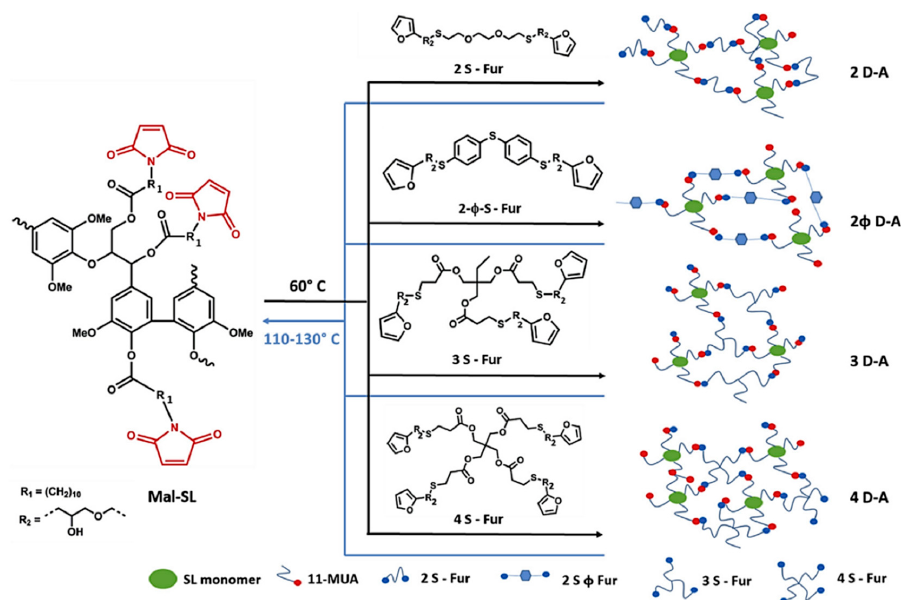
Figure 35. Thermo-reversible D-A polymerization of maleimide grafted lignin with the multifunctional furan linkers. Reproduced with permission [116].